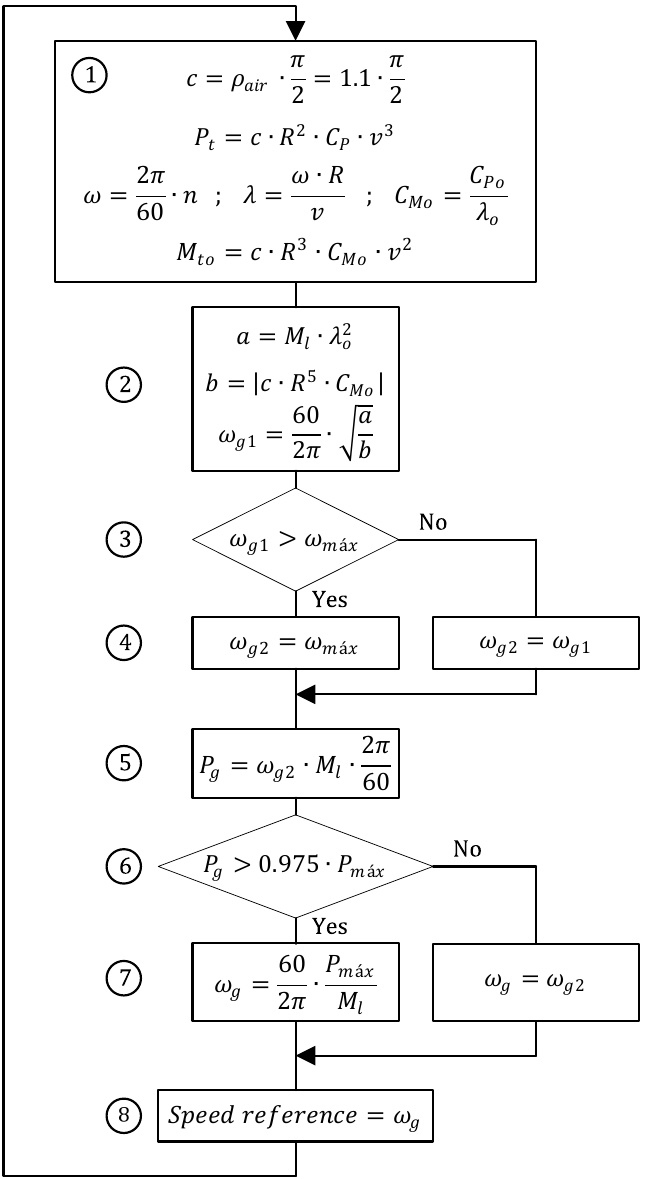
Figure 5. Control algorithm and meaning of the